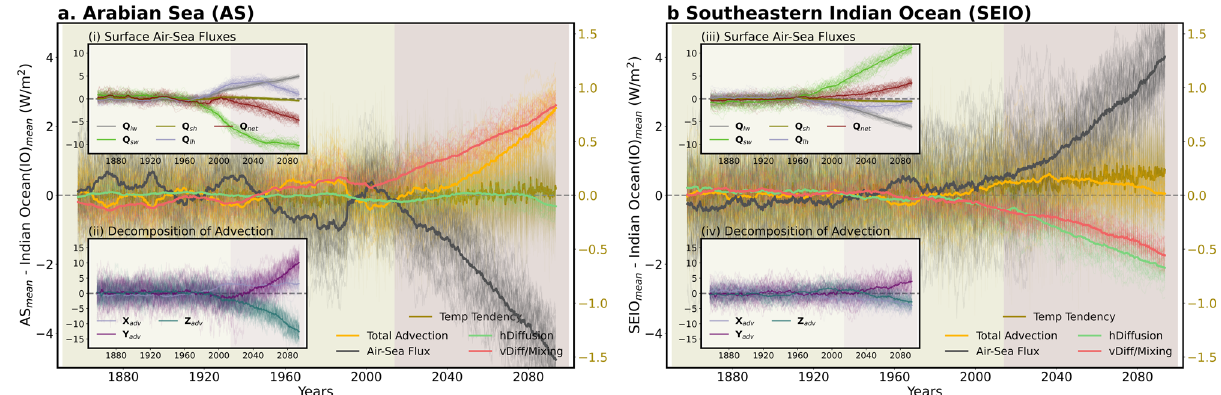
Fig. 2 | Contribution of different factors to the forced warming pattern. Time series of each term of vertically integrated (0 – 65m) ocean heat budget equation overthe a ArabianSea (AS)from1850 – 2100for 50ensemblemembers(pleasesee the “ Methods ” for more details). Inset plot (i) in ( a ) shows the time series of each component of surface air-sea fl ux (positive values represent anomalous heat input intotheocean)componentssuchasshortwaveradiation(Q sw ),longwaveradiation (Q lw ),sensibleheat fl ux(Q sh ),latentheat fl ux(Q lh ) , andnetsurfaceair-sea fl ux(Q net )